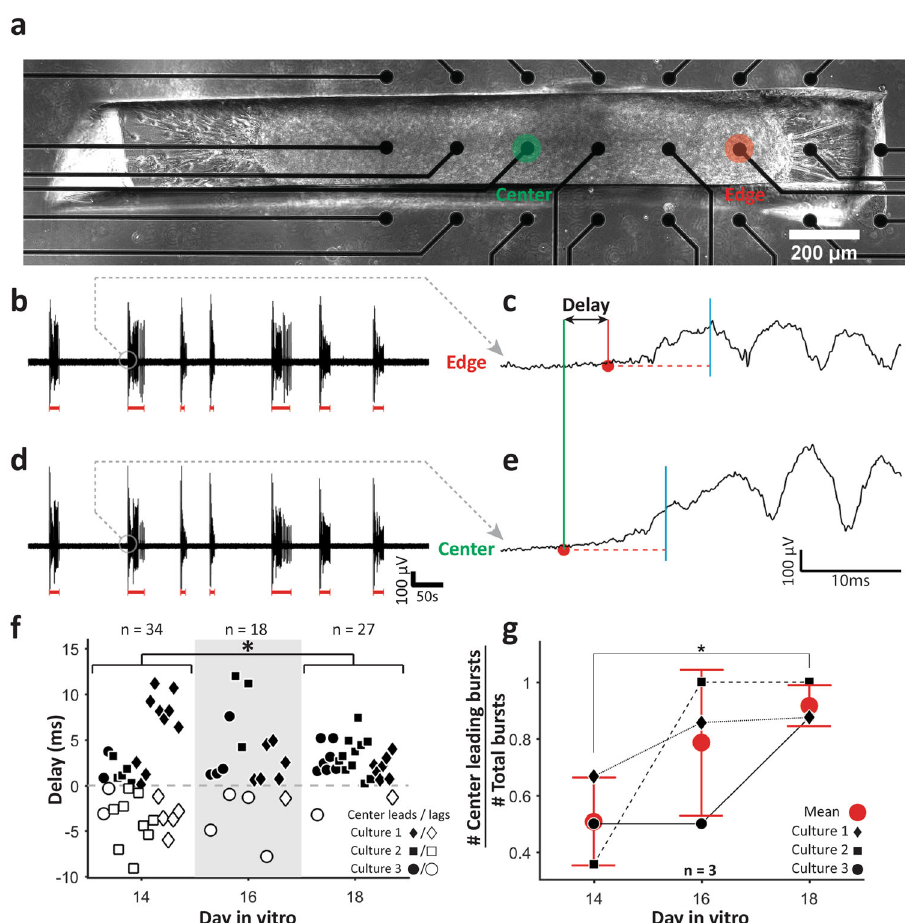
Fig. 5 Local fi eld potential (LFP) analysis. a Phase contrast image of a 3D linear culture on a multi-electrode array. Active channels at edge (red) and center (green) are marked by text and fi lled circles. Recorded LFPs from edge ( b ) and, center ( d ) electrode with detected bursts indicated by red lines. Zoomed in traces for the same burst (marked by gray circles in b and d from edge ( c ) and center ( e ) electrodes, respectively. Red circles indicate bursts ’ initiation times. Red horizontal dashed line indicates threshold, cyan vertical line after threshold line indicates the time point (10 ms after trace crosses threshold) until which the trace must remain above threshold (red dashed line) for the initiation time to be registered. f Beeswarm plots of delays between burst initiations at edge and at center on different DIVs. Black fi lled and white fi lled shapes indicate that burst fi rst initiated at the center or at the edge, respectively. g Mean± standard deviation of the ratio of bursts initiating at the center (center leading bursts) and total detected bursts on different DIVs. Three cultures were recorded for all panels. For f and g , asterisks indicate results of two-sample Kolmogorov – Smirnov test (* p < 0.05, ** p < 0.01, and *** p <